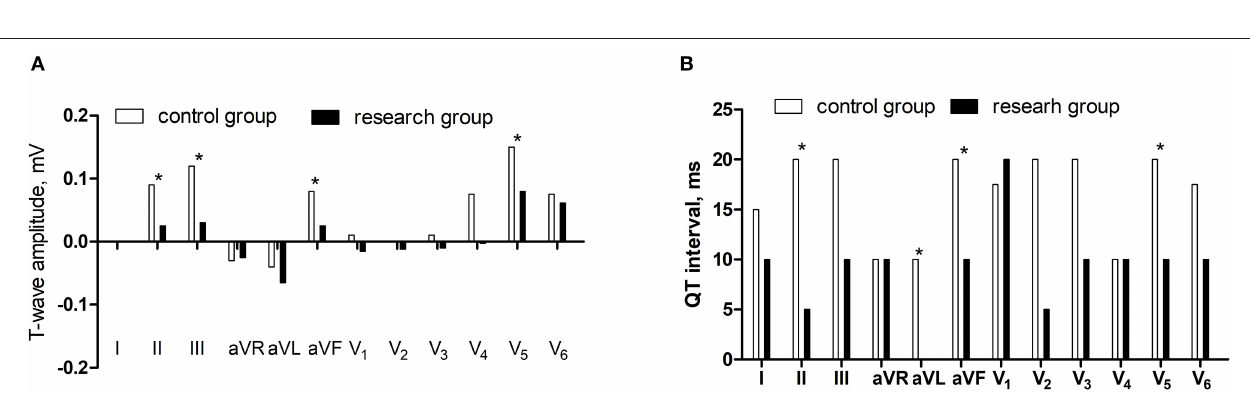
difference in lead III was − 0.01 mV, the sensitivity and specificity were 39.7 and 94.4%. The best cutoff value of QT interval difference in lead aVL was 25 ms, the sensitivity and specificity were 82.0 and 37.0% ( Figure 4